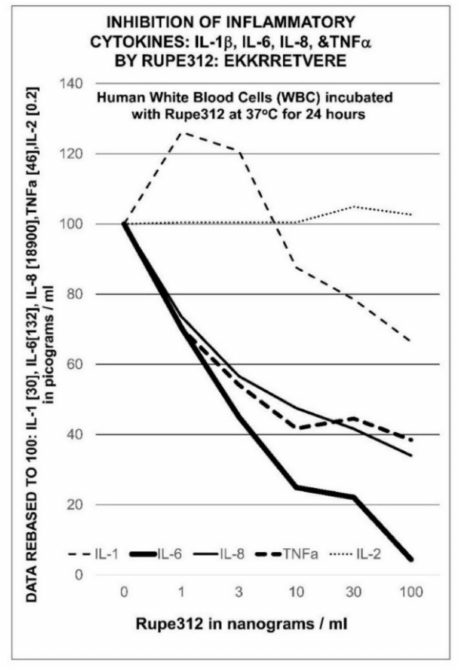
Figure 7. Inhibition of inflammatory cytokine expression in human WBC induced by 3 µ g/mL PHA (phytohaemagglutinin) at 37 ◦ C for 24 h, by ezrin peptide Rupe312 (the active sequence of RepG3) at concentrations of 1, 3, 10, 30, 100 nanograms per mL culture medium. Cytokine concentrations were measured in picograms per mL then expressed relative to the zero-Rupe312 control-value rebased to